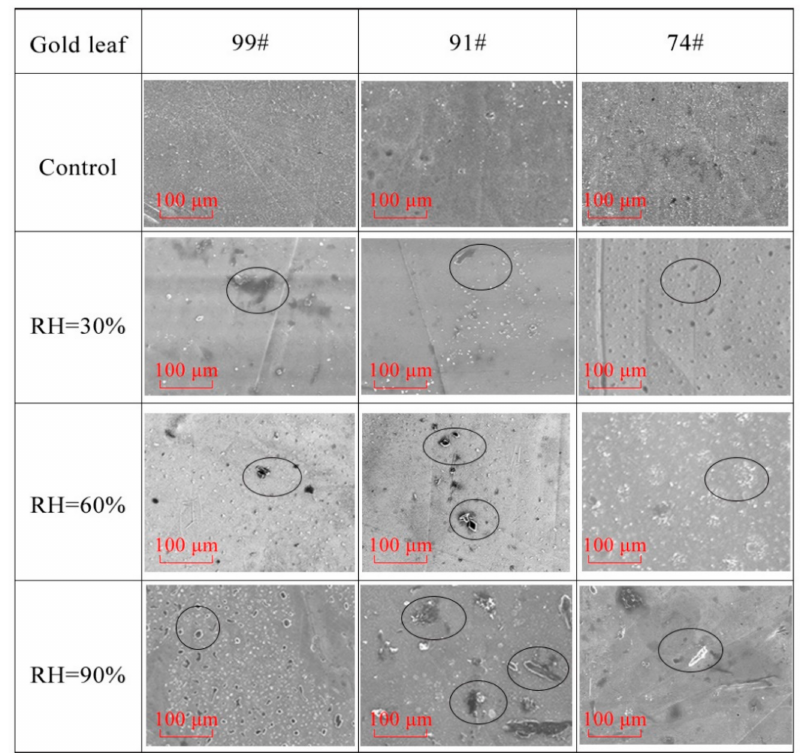
Figure 5. SEM micrographs of the control group and corroded group (magnification = 1000 × ).